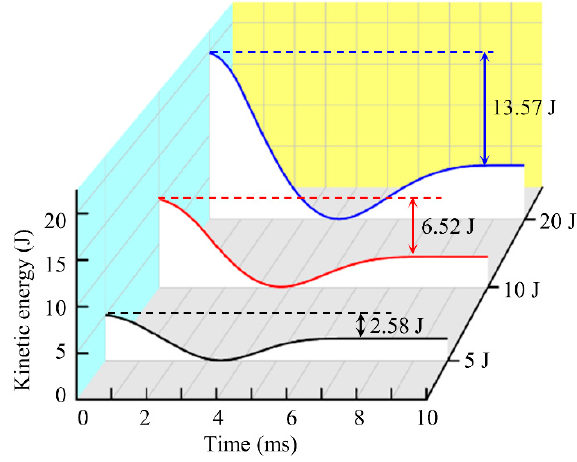
Figure 9. Kinetic energy-time curve of impactor for various impact energies.